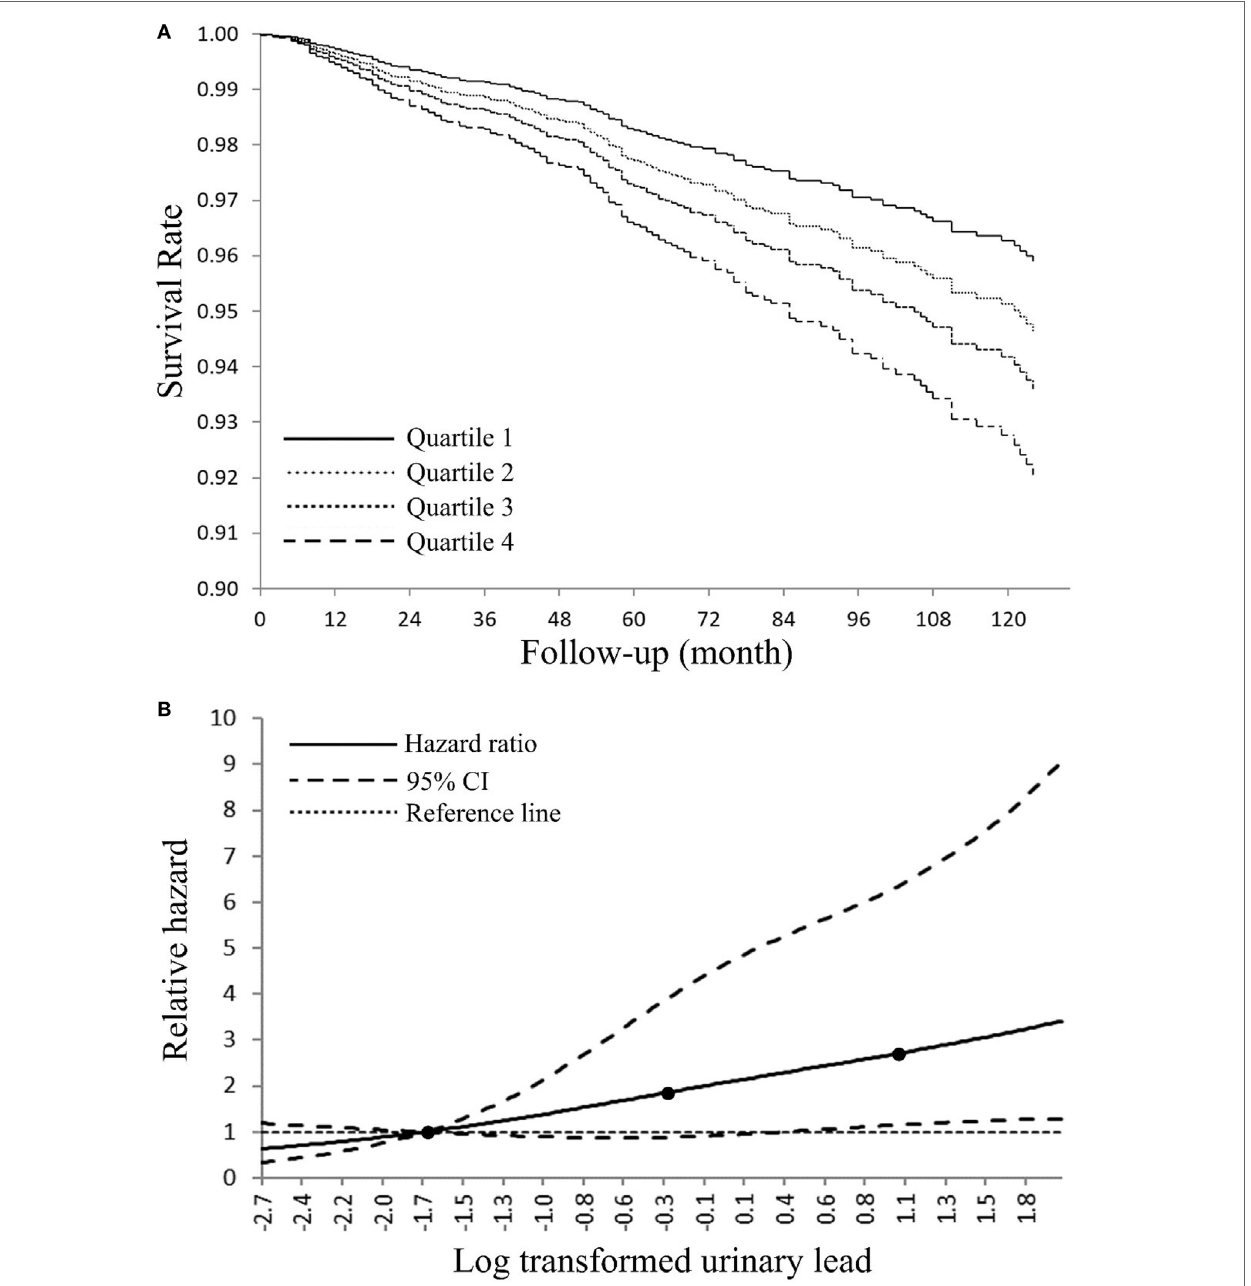
FigUre 2 | (a) Adjusted Kaplan–Meier survival curves for cumulative cancer mortality according to urinary lead quartile—National Health and Nutrition Examination Survey (NHANES) 1999–2010. Urinary lead quartiles: quartile 1: ≤ 0.40 μ g/L; quartile 2: 0.41–0.73 µg/L; quartile 3: 0.74–1.26 µg/L; quartile 4: > 1.26 μ g/L. (B) Adjusted dose–response association between log transformed urinary lead and risk for cancer-related death-NHANES 1999–2010. Log transformed urinary lead was coded using a restricted cubic splines function with three knots (black dots) located at 5th, 50th, and 95th percentiles of its distribution. Y -axis represents the adjusted hazard ratio for cancer mortality for any value of log transformed urinary lead compared with a referent level of fifth percentile of its